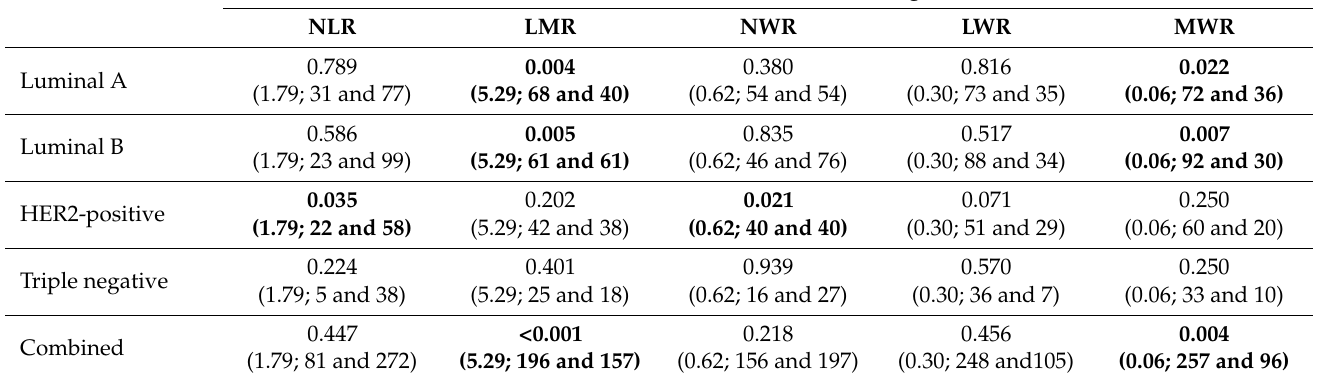
Table 8. Immunocyte ratio cut-off correlation with